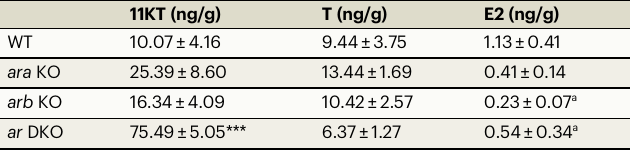
Table 1 | LC/MS analysis of androgen and oestrogen in